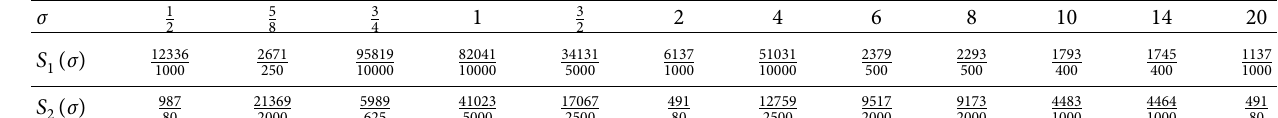
Figure 1: Graphs of S